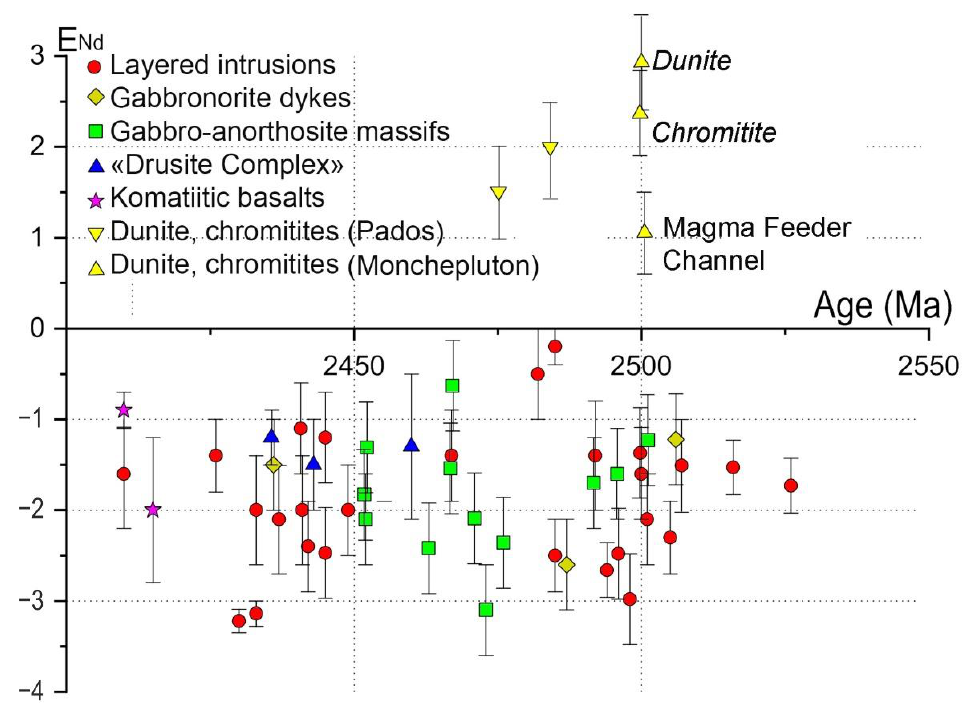
Figure 20. Variations in the initial ratio of ε Nd(T) in rocks of the Paleoproterozoic layered intrusions; massifs of gabbro-anorthosites and the “Drusite Complex”; and komatiitic basalts of the Kola Region, Karelia, and Finland. Layered intrusions: the Monchepluton, Fedorovo–Pansky Complex,